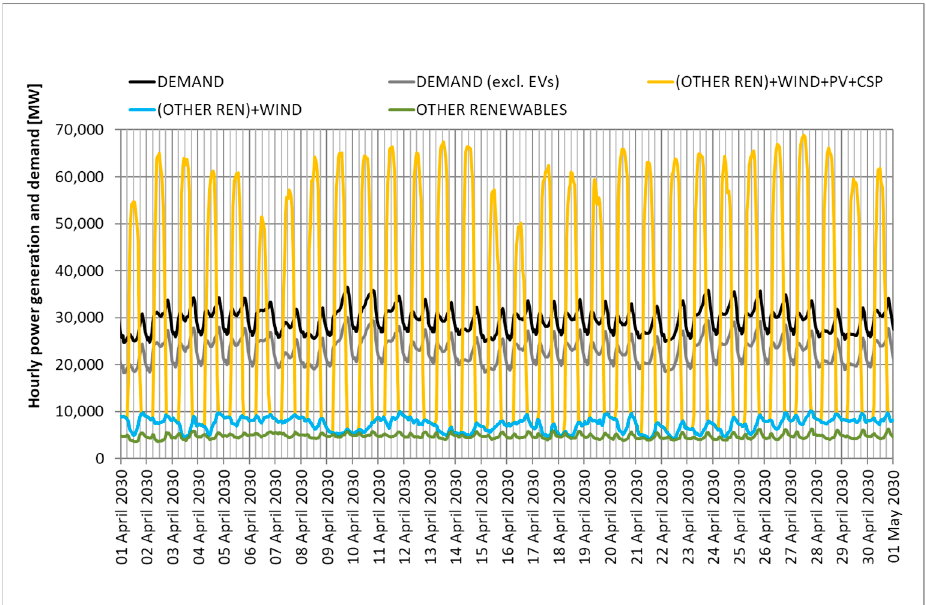
Figure 5. Projected hourly electricity demand and potential generation (i.e., pre-curtailment and storage) for the month of April 2030, in the “High BEV DMS” and “High BEV DMS + V2G” scenar- ios.